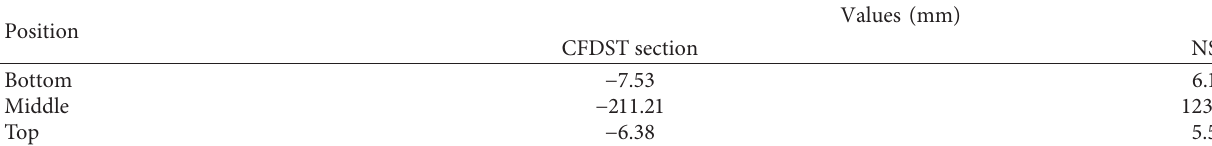
Values (mm) CFDST section NSS